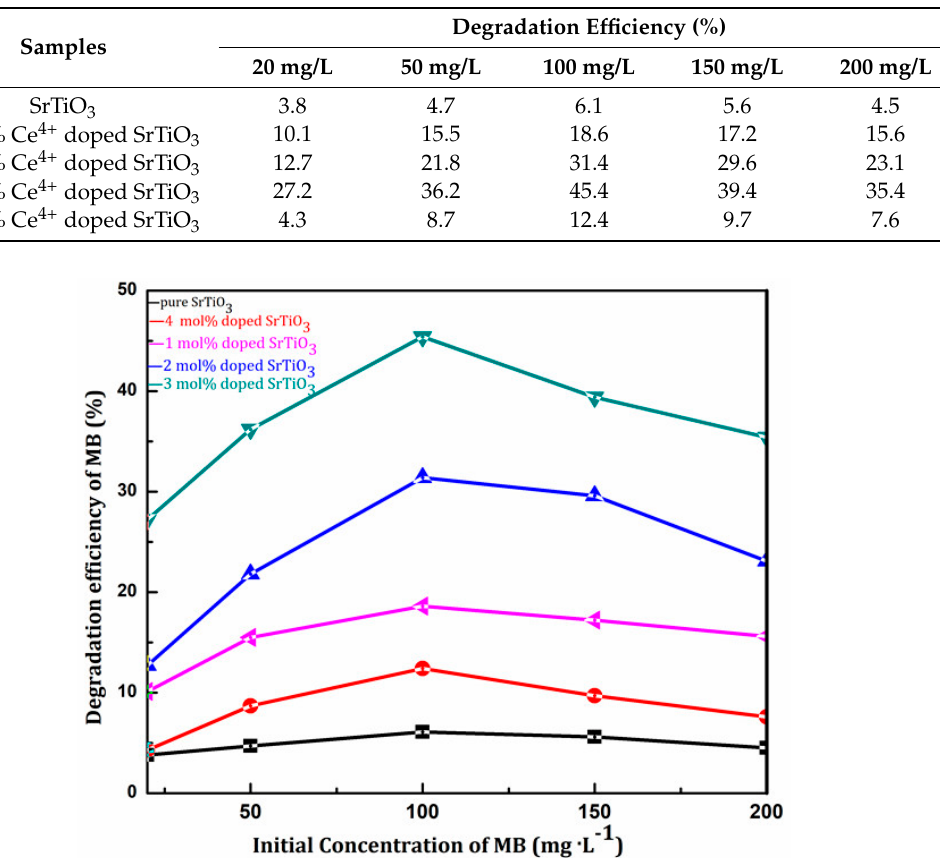
Figure 11. Effect of initial concentration on photocatalytic activity. ( black ) pure SrTiO 3 ; ( purple ) 1 mol % Ce 4+ doped SrTiO 3 ; ( blue ) 2 mol % Ce 4+ doped SrTiO 3 ; ( green ) 3 mol % Ce 4+ doped SrTiO 3 ; ( red ) 4 mol % Ce 4+ doped SrTiO 3 .